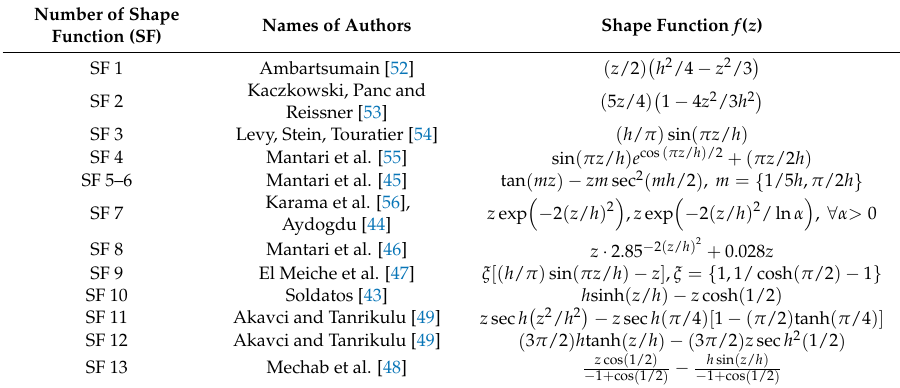
Table 1. Shear deformation shape functions.